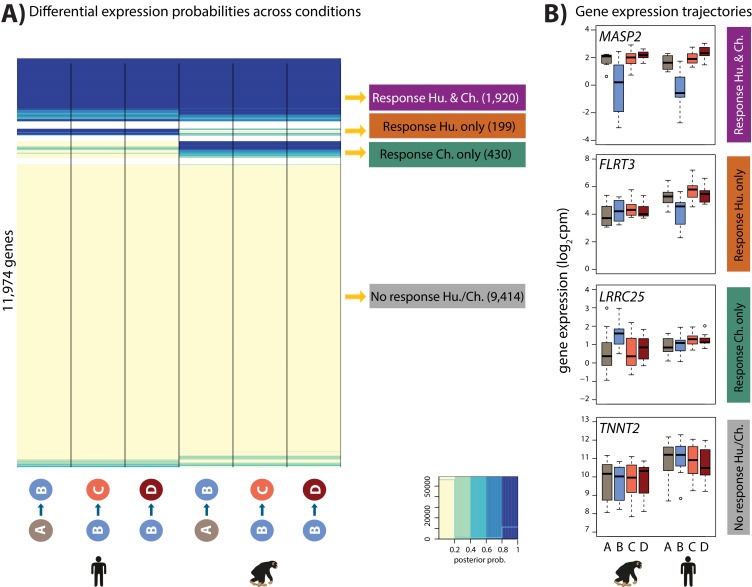
Four gene expression response categories can be classified following hypoxia.(A) Posterior probabilities of genes being differentially expressed across pairs of conditions. Genes are categorized based on their posterior probabilities: genes with a p<0.5 across all tests are designated as ‘Non-response genes’ (grey), genes with a p>0.5 across all tests are designated as ‘Conserved response genes’ (magenta), genes with p>0.5 in human comparisons only are designated as ‘Human-specific response genes’ (orange), and genes with p>0.5 in chimpanzee comparisons only are designated as ‘Chimpanzee-specific response genes’ (green). (B) Examples of genes belonging to each of the four categories. Also see Figure 5—figure supplement 1.